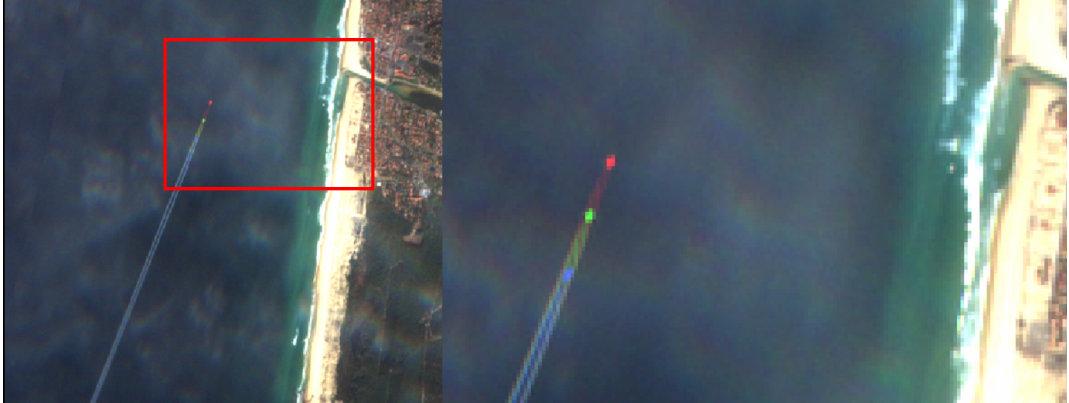
Figure 1. Illustration of the time-lag between detector bands B02 (blue), B03 (green) and B04 (red) by the different colors of the flying airplane at Capbreton, France. The time-lag between each band is 0.527